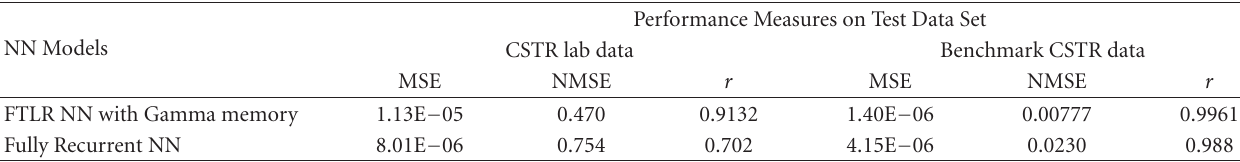
Table 5: Comparison of NN